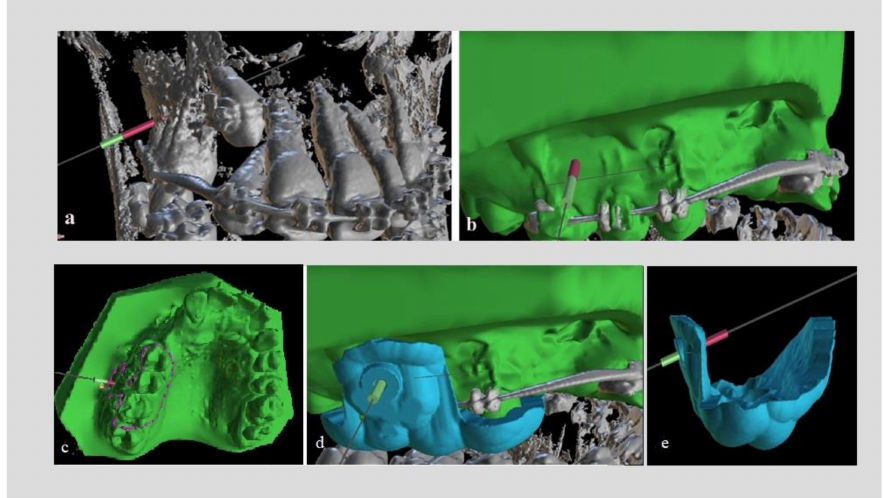
Figure 1. ( a ) Cone-Beam Computed Tomography (CBCT) image with virtual mini-implant in place. ( b ) Digital model A: Digital Imaging and Communications in Medicine (DICOM) and stereolithogra- phy (.stl) files combined. ( c ) Design of the surgical guide on the digital model. ( d , e ) .stl model of the surgical